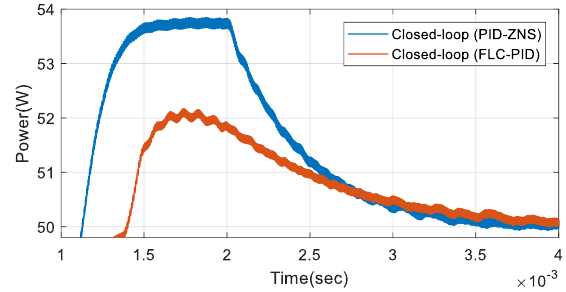
Fig.15: Power signal for the proposed ESU with PID-ZNS and FLC- PID controller